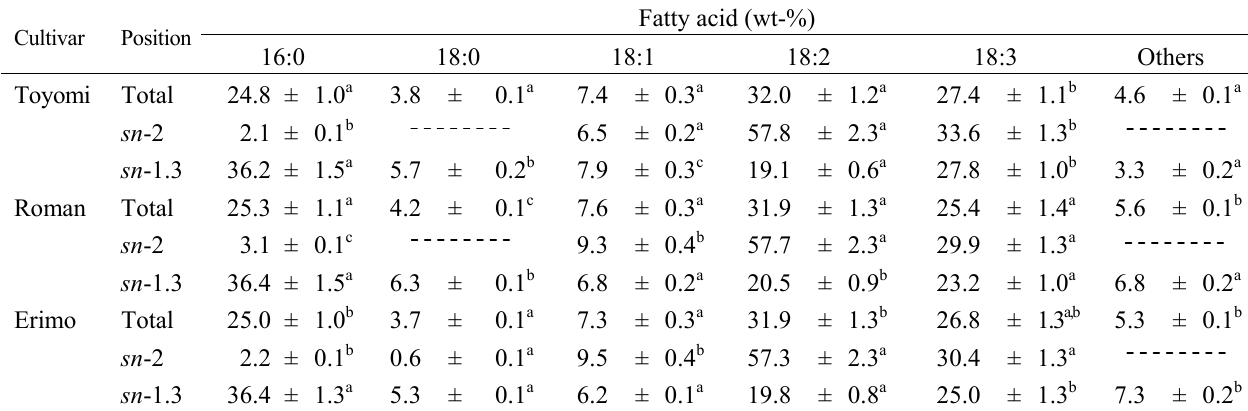
Table 2. Composition and positional distribution of fatty acids in the triacylglycerols isolated from adzuki beans †